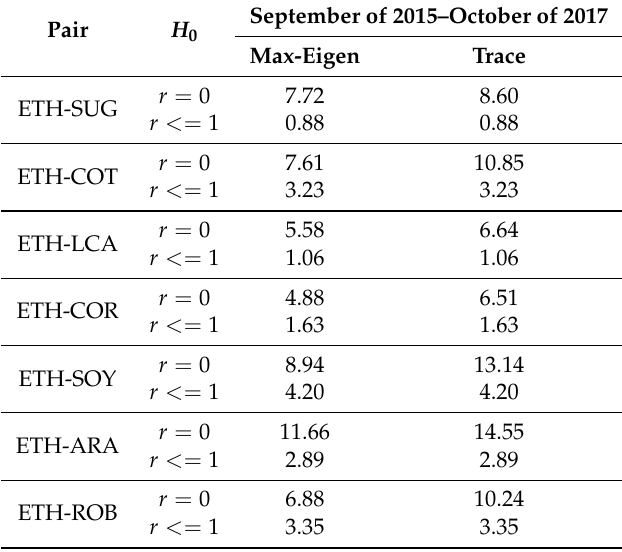
Table A5. The Johansen test for P 4 .